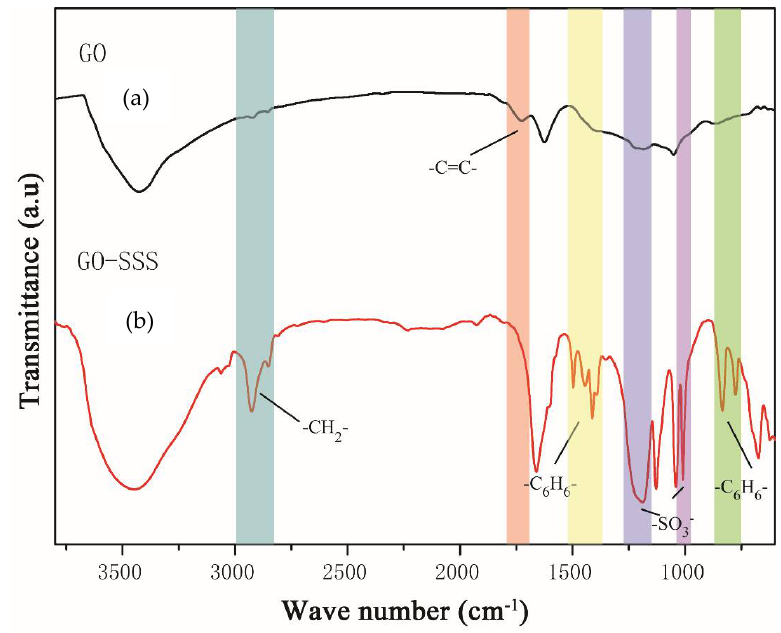
Figure 4. FT-IR spectra of ( a ) GO, ( b ) modified GO.